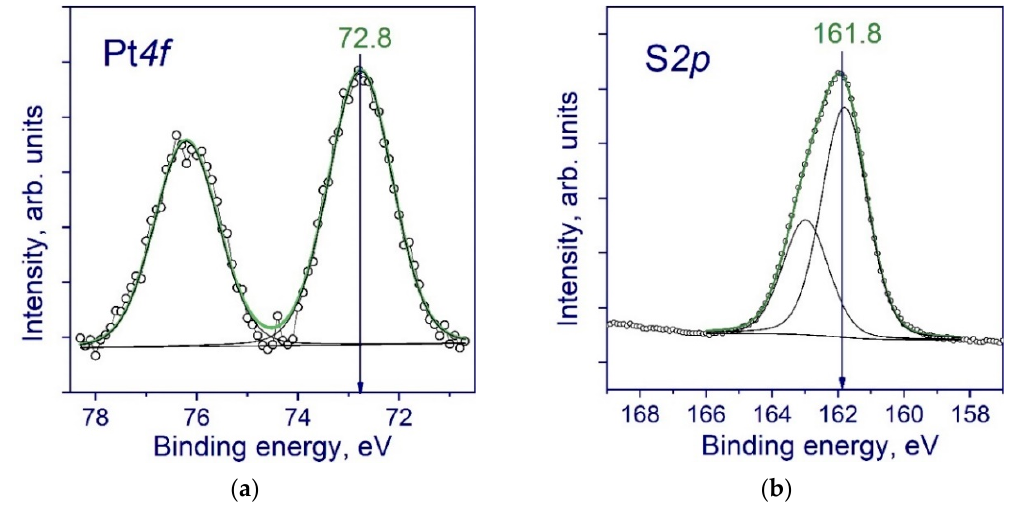
Figure 2. The Pt 4f ( a ) and S 2p ( b ) X-ray photoelectron spectroscopy (XPS) spectra of the synthesized photocatalyst.